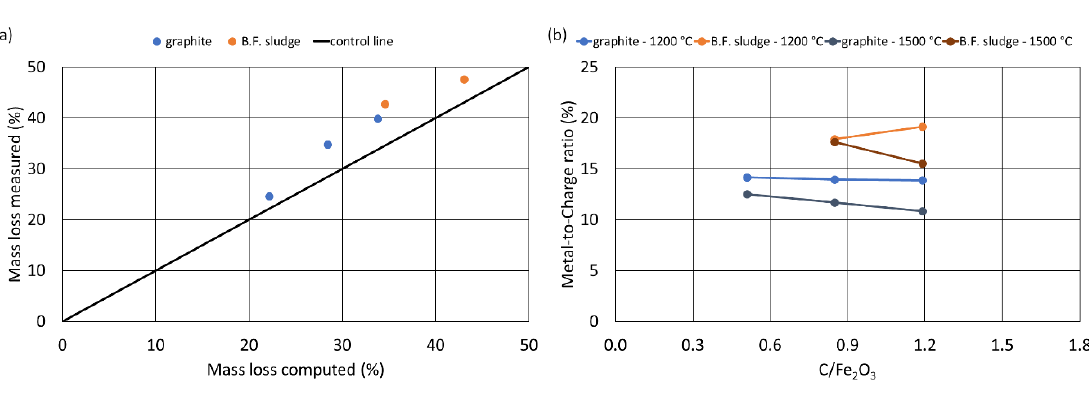
Figure 8. Computed versus measured mass loss at 1500 °C ( a ), metal-to-charge ratio as a function of C/Fe 2 O 3 ratio ( b ).